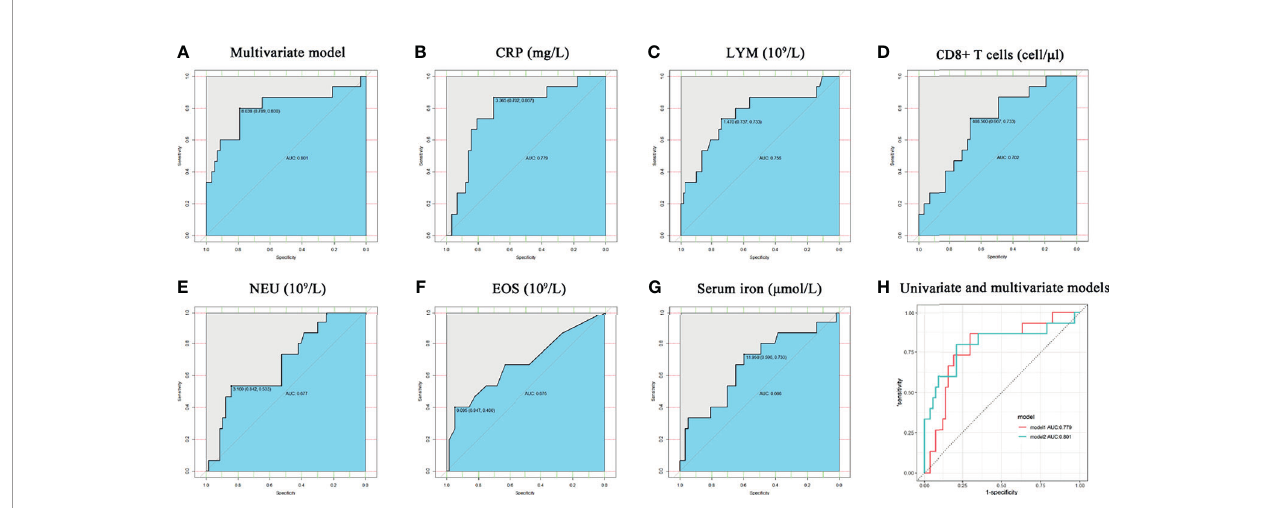
FIGURE 2 | Non-parametric ROC analysis of meaningful variables. (A – G) the model combining NEU and LYM counts, CRP, LYM counts, CD8+ T cell counts, NEU counts, EOS counts, and serum iron. all P < 0.05. (H) Comparison between ROC curves for CRP univariate model and multivariate model combining NEU and LYM counts. Model1 represents the CRP univariate model, and model2 represents the multivariate model combining NEU and LYM counts. ROC, Receiver operating curves.